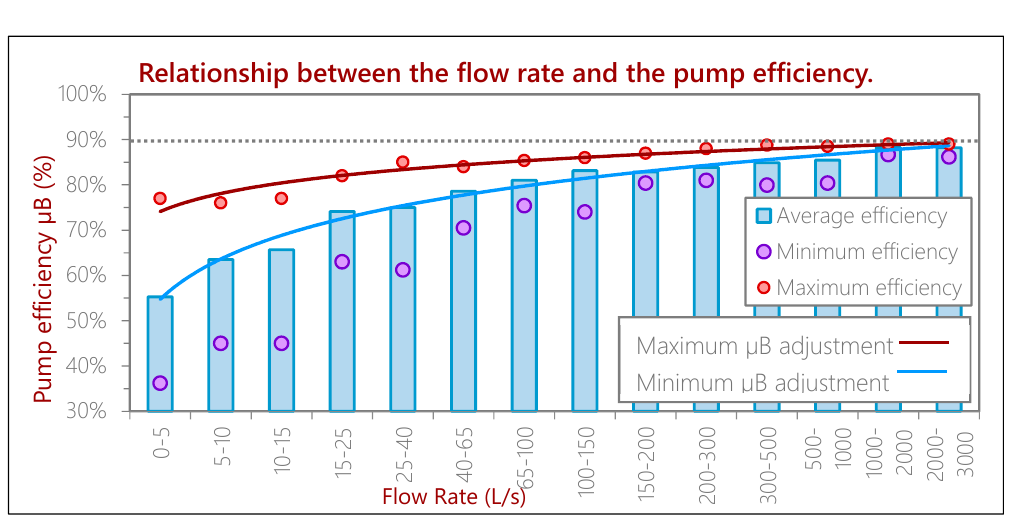
Figure 5. Adjusted curves. The curves are elaborated using 14 intervals of the collected data.